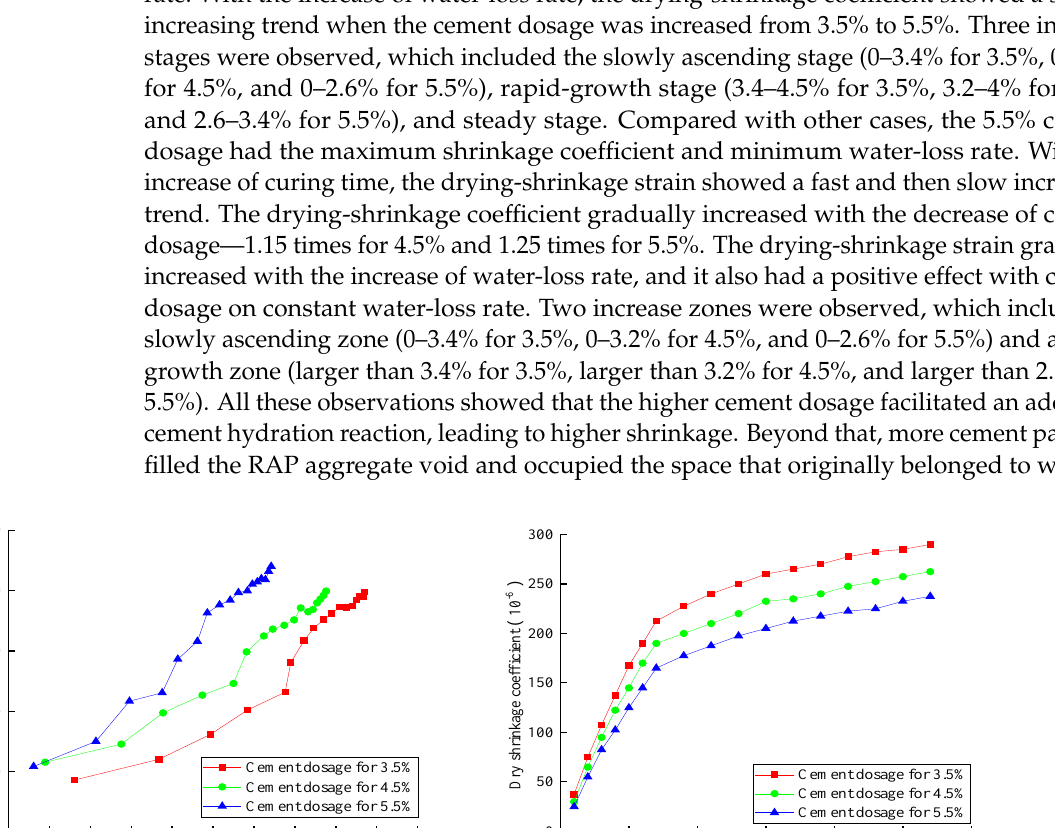
Figure 19. Analysis of the temperature shrinkage coefficient. 3.5. Freeze-Thaw Cycle and Water-Stability Tests With the increase of curing time from 28 to 90 days, both the mass and strength loss rate gradually decreased the exact cement dosage, as shown in Figure 20. For the same curing time, the increased cement dosage had a positive effect on maintaining the strength